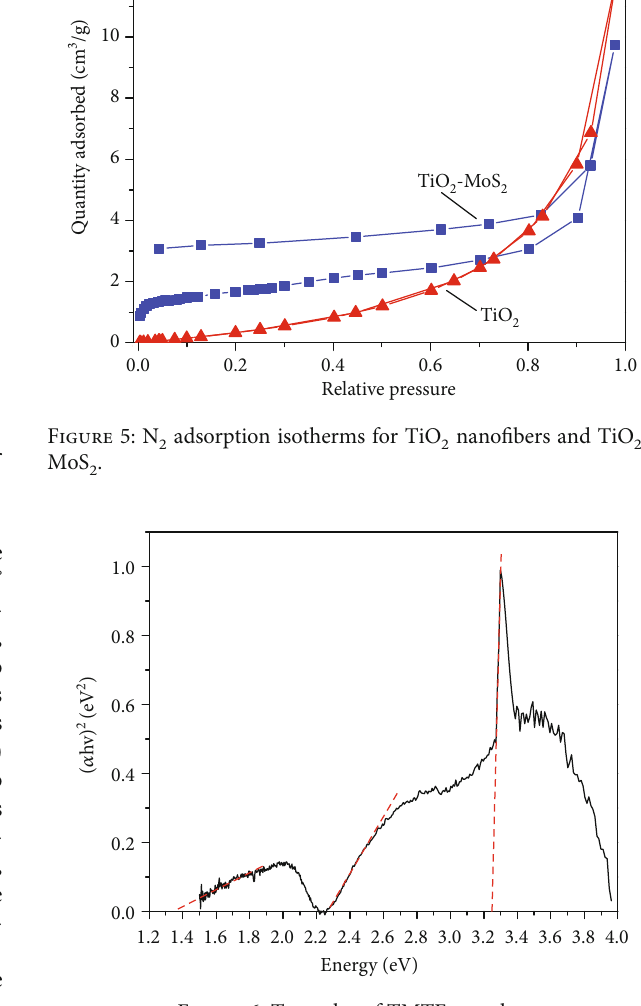
Figure 6: Tauc plot of TMTF